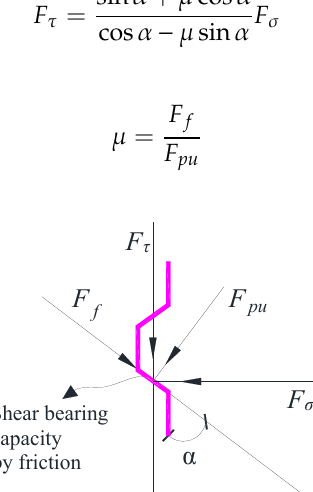
Figure 11. Shear bearing capacity by friction at the key interface.